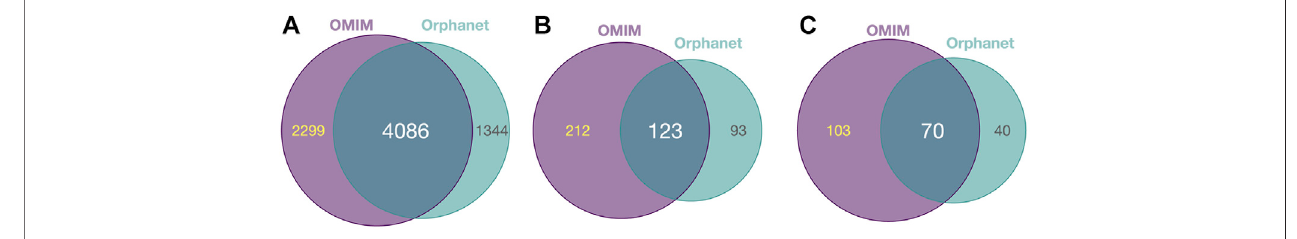
FIGURE 2 | Common and distinct disease-associated HPO-phenotypes in OMIM and Orhpanet described in Table 2 . (A) : Distribution of the 6 385 HPO phenotypes for OMIM and the 5 430 phenotypes for Orphanet for all NMDs and non-NMDs. (B) : Distribution of the typical 335 OMIM and 216 Orphanet phenotypes signi fi cantly ( P < 0 . 05) associated with NMDs. (C) : Same as B, but using the increased signi fi cance ( P < 0 . 001) NMD-associated phenotypes (172 for OMIM and 110 for